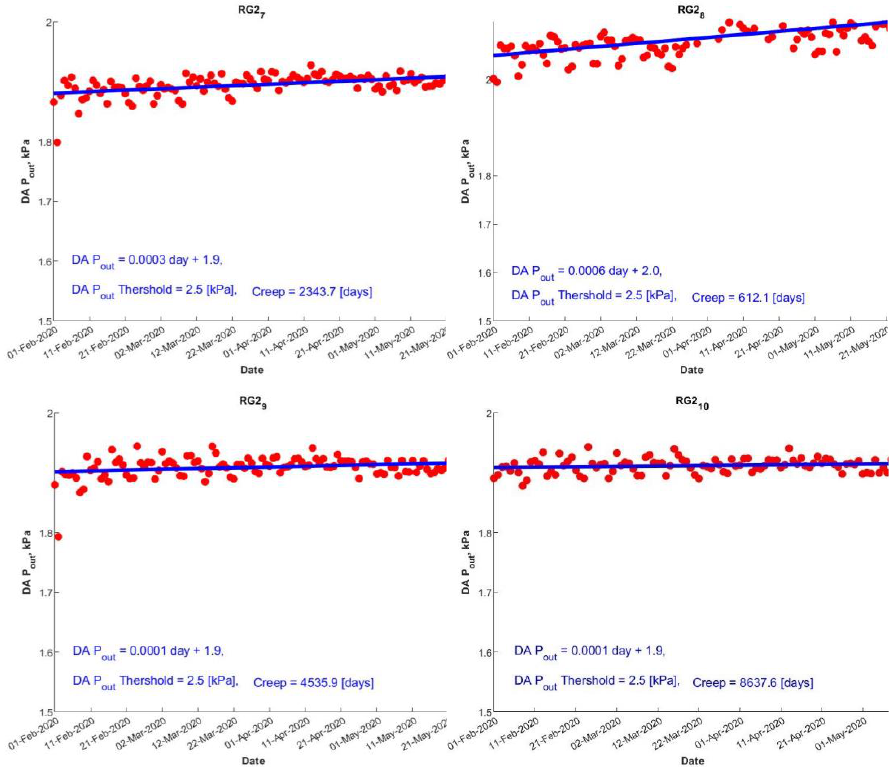
Figure 9 and Table 2.